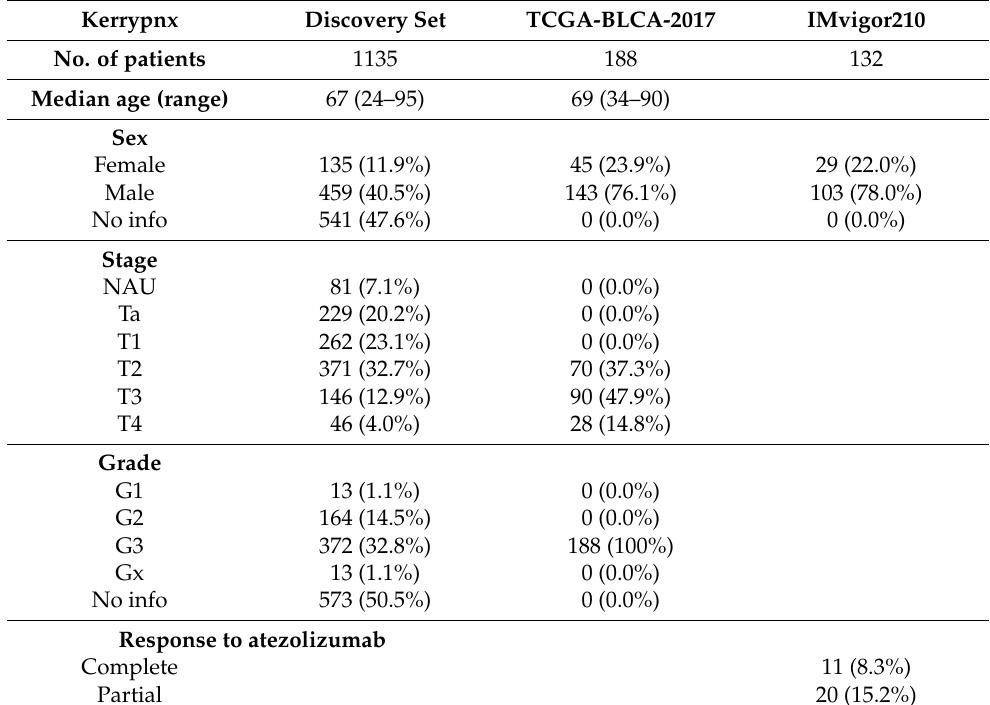
Table 1. Clinical data of the cohorts